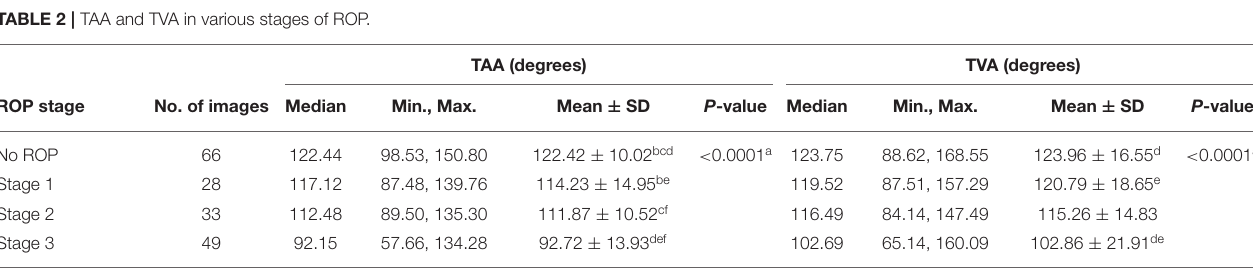
TABLE 2 | TAA and TVA in various stages of